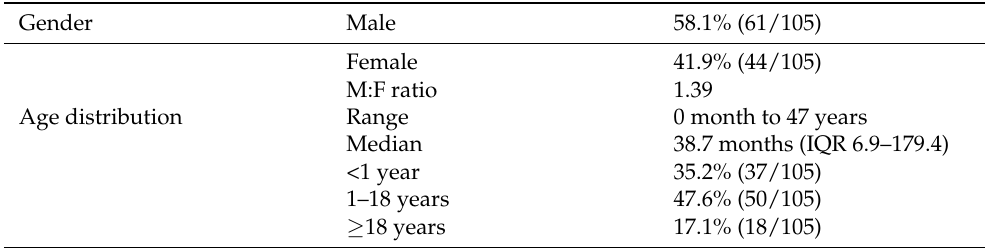
Table 1. Demographic characteristics.